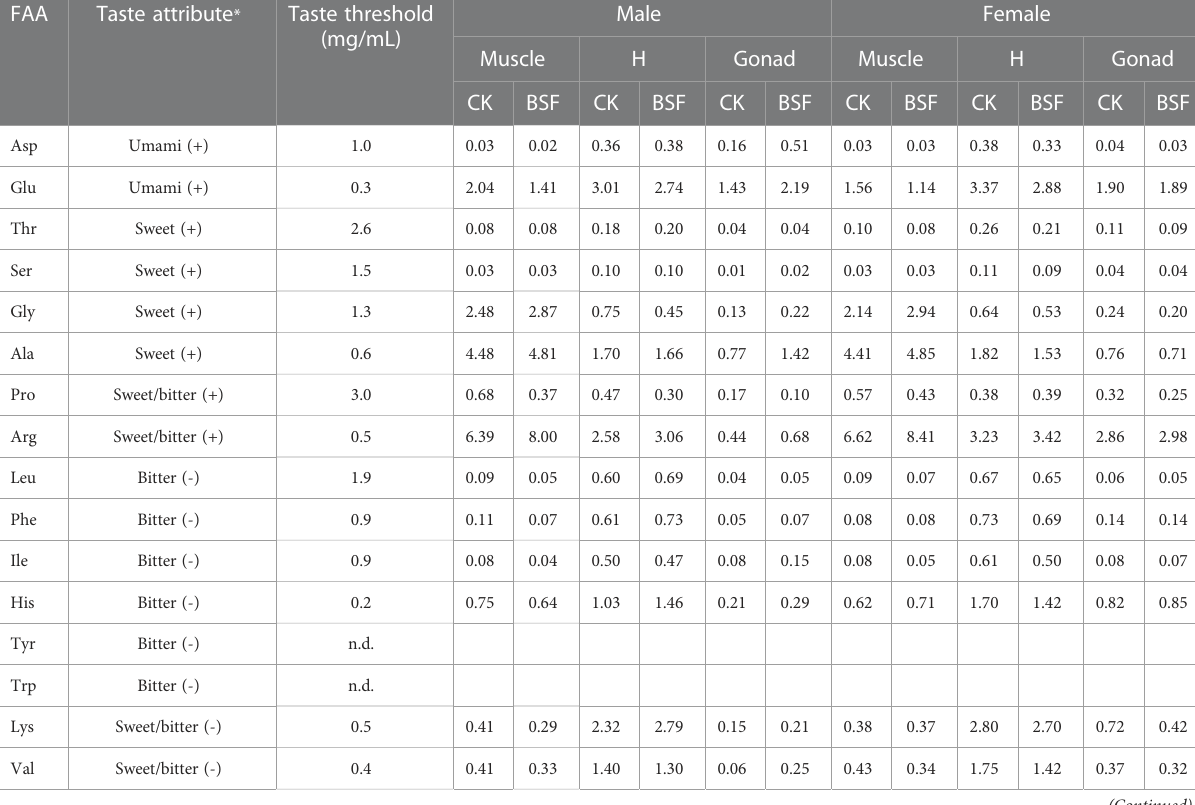
TABLE 2 Effects of BSFL feeding on the TAVs of free amino acids in edible tissues. FAA